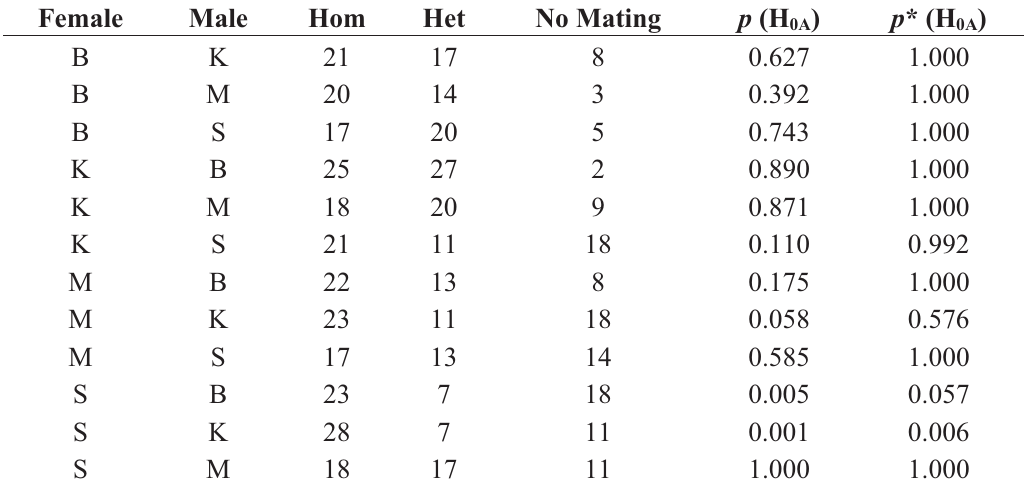
Table 4. Female-choice experiment (1 female/2 males). The three categories were: homogeneous crosses, (Hom), heterogeneous crosses (Het), and no mating. Departure from the random mating hypothesis (H 0A : as many homogeneous as heterogeneous crosses) was quantified using the bilateral binomial p -value. Multiple testing-corrected p -values (Holm-Bonferroni correction) are indicated as p * ; B: Bioko; K: Kounden; M: Mayotte; S: Sao-Tome.